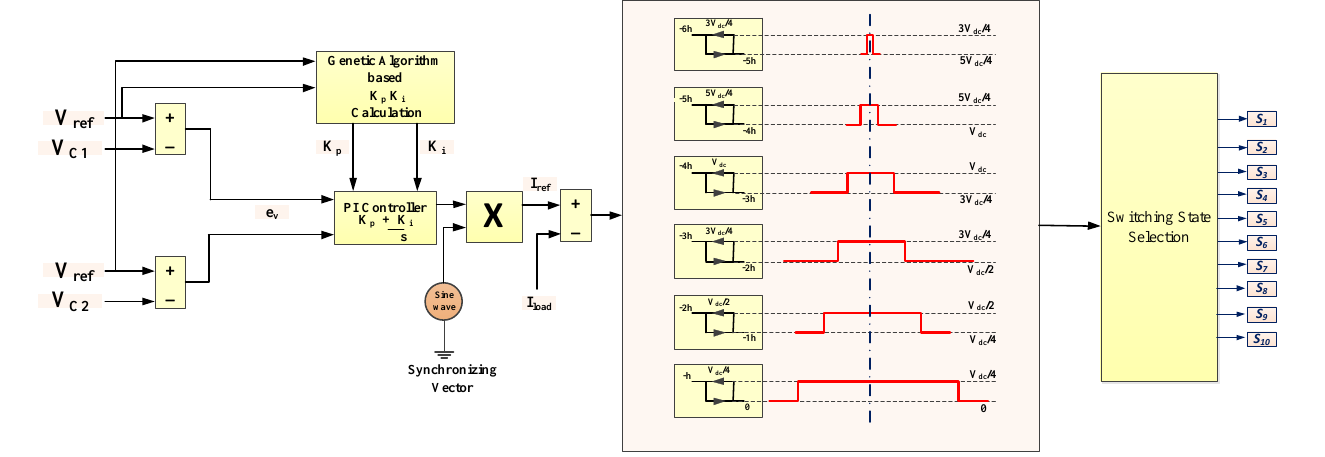
Figure 3. Hysteresis band control implementation with GA based tuning.